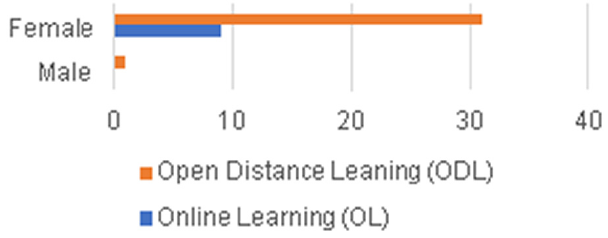
Fig. 2. Teaching and learning approach preference by